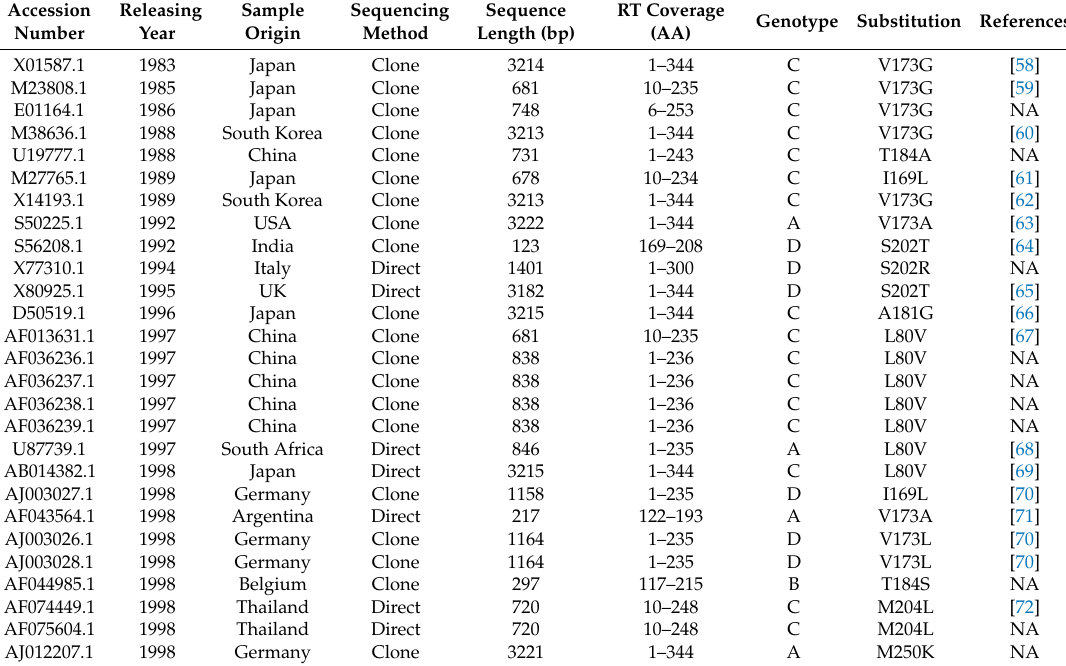
Table 3. Characteristics of the RT sequences with NUCr-related AA